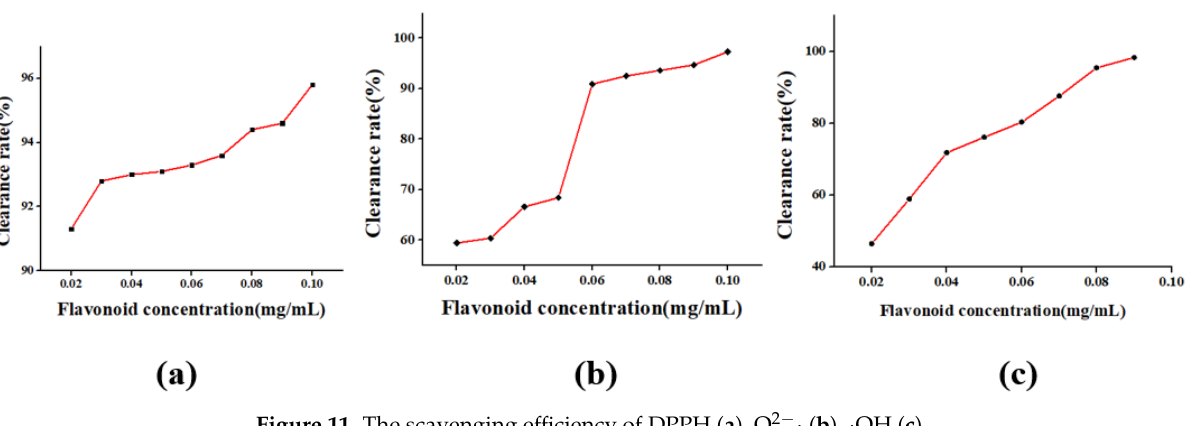
Figure 11. The scavenging efficiency of DPPH ( a ), O 2- · ( b ), ·OH ( c ).